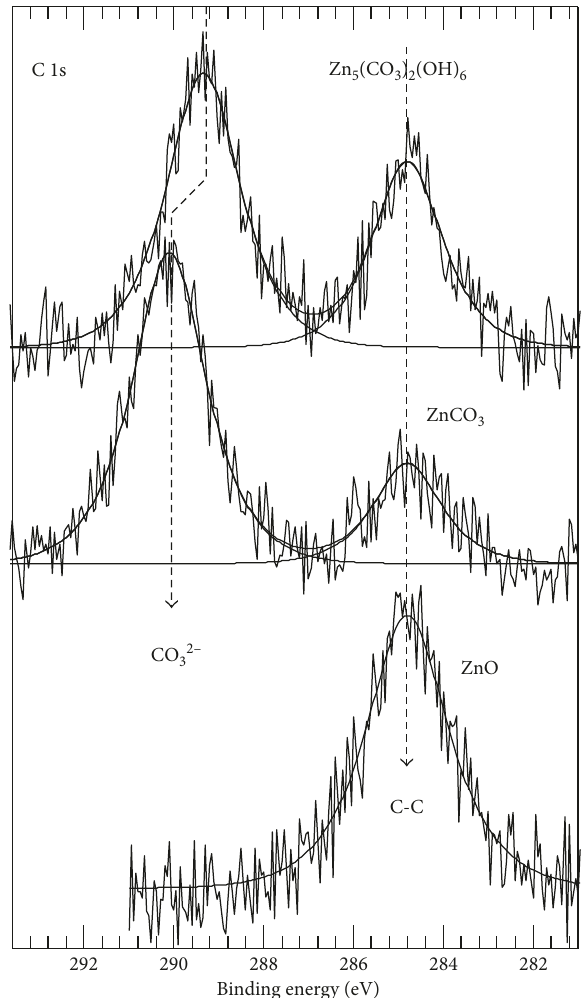
Figure 8: C 1s photoelectron spectra for Zn